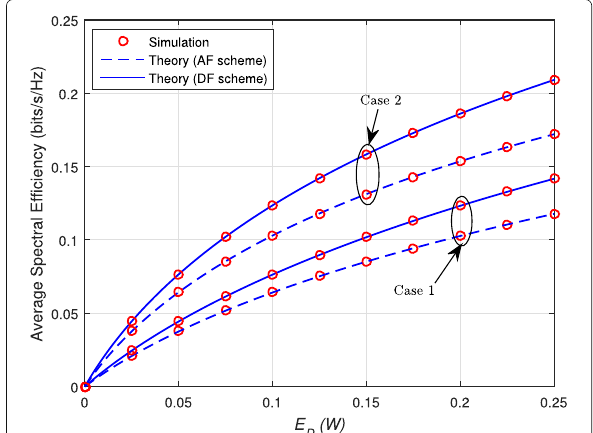
Fig. 9 Average SE versus E D (W) in case 1 and case 2 at UE3